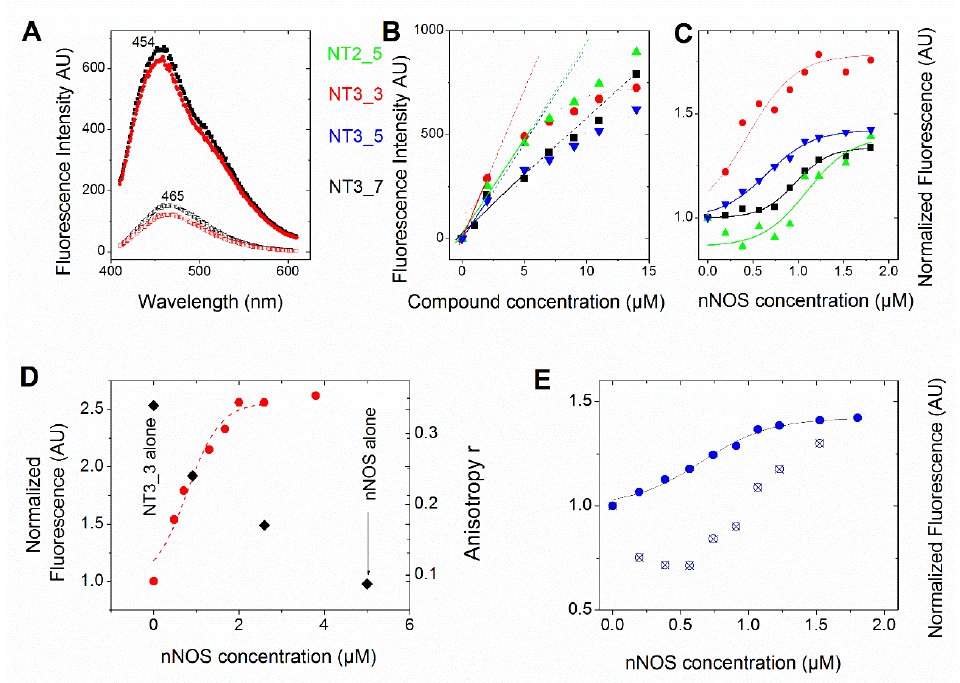
Figure 2. Comparison of the affinity of the NTs for NOS (see also Table 1). In all panels, we used the